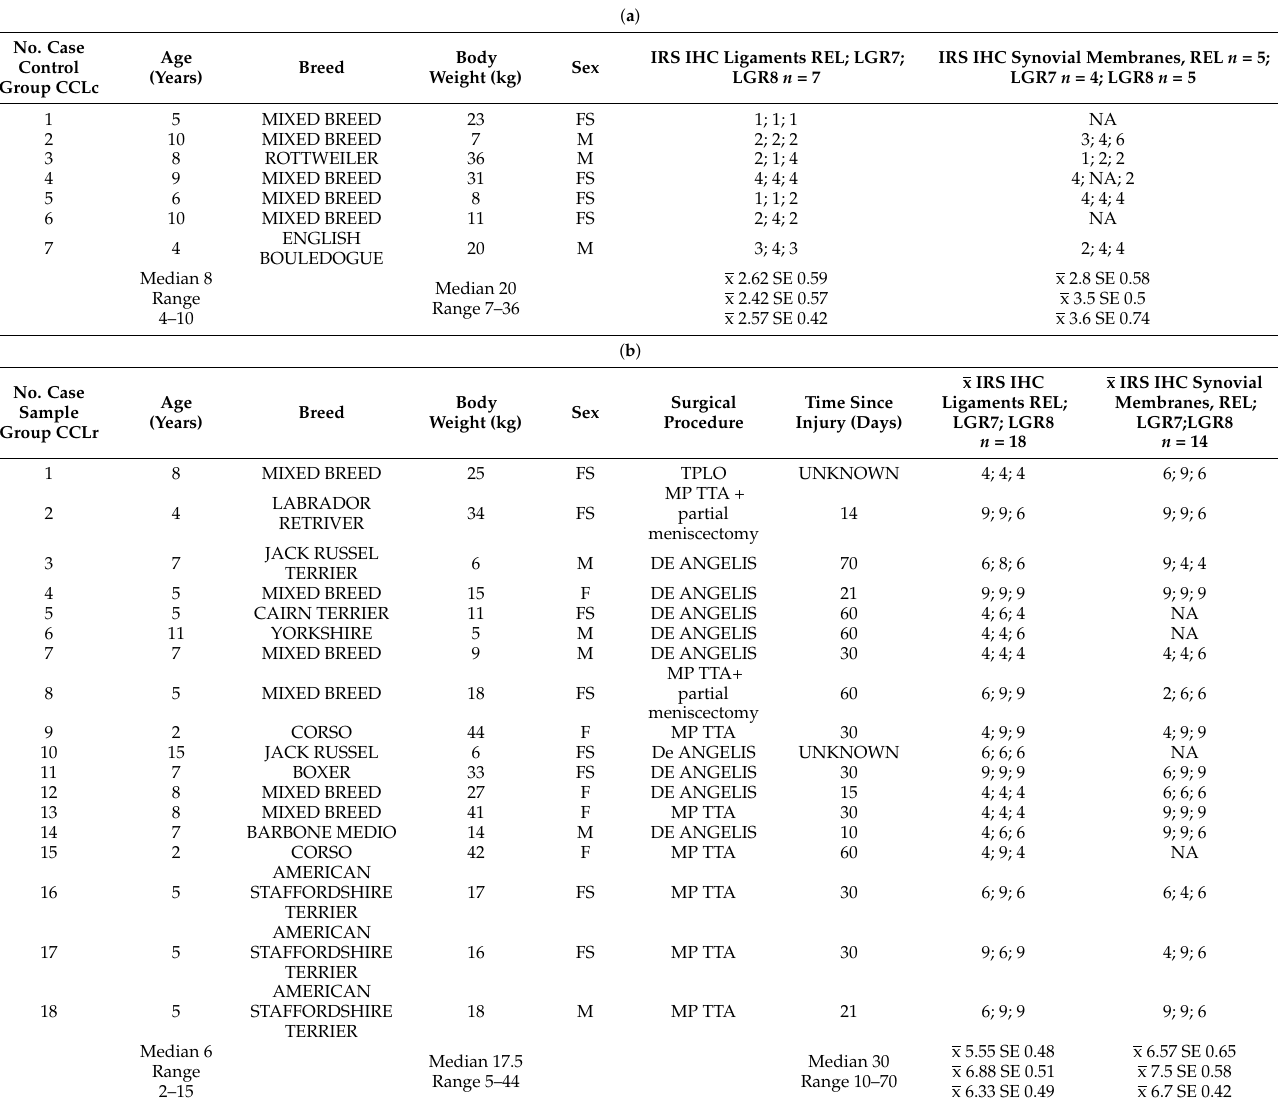
Table 1. The two columns to the right show the mean immunoreactivity scores (IRS) on IHC in cruciate ligaments and synovial membranes, respectively; in each column, the first vertical row of numbers represents relaxin-specific IRS, the second row LGR7-, and the third LGR8-specific IRS for each dog. Abbreviations: MP modified Maquet procedure; TTA tibial tuberosity advancement; TPLO tibial plateau levelling osteotomy; DE ANGELIS extracapsular suture stabilization; M male; F female; FS female sterilized, NA not available. ( a ) Seven control dogs without CCL damage (CCLc). ( b ) Eighteen dogs with CCLD